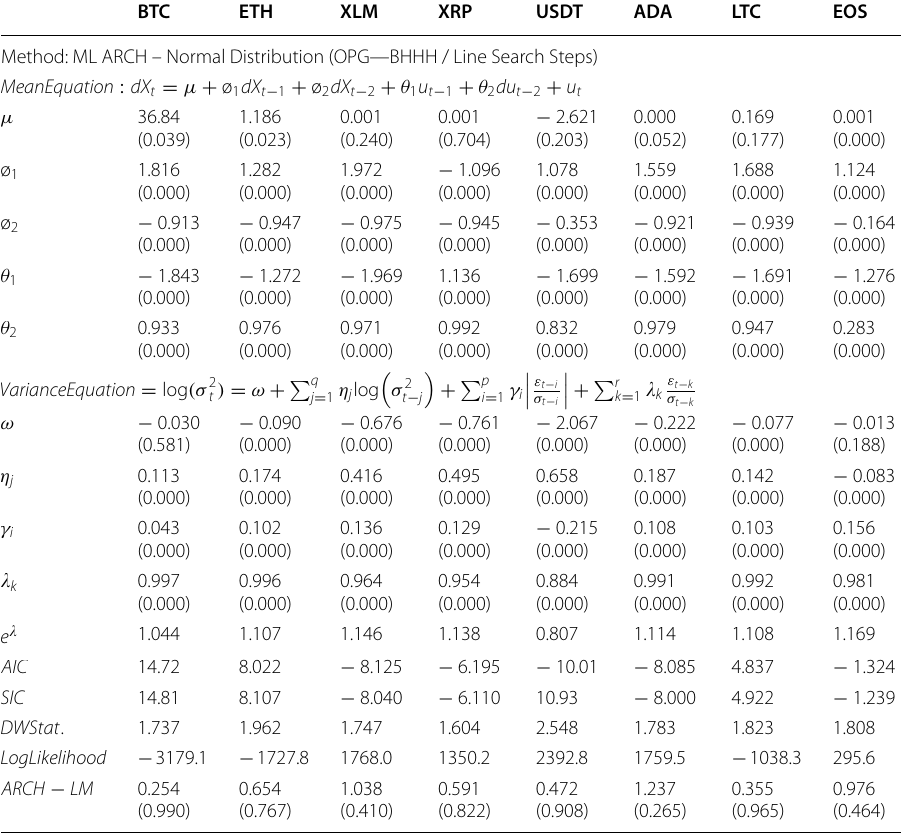
Table 5 The estimation results of EGARCH (1,1,1)